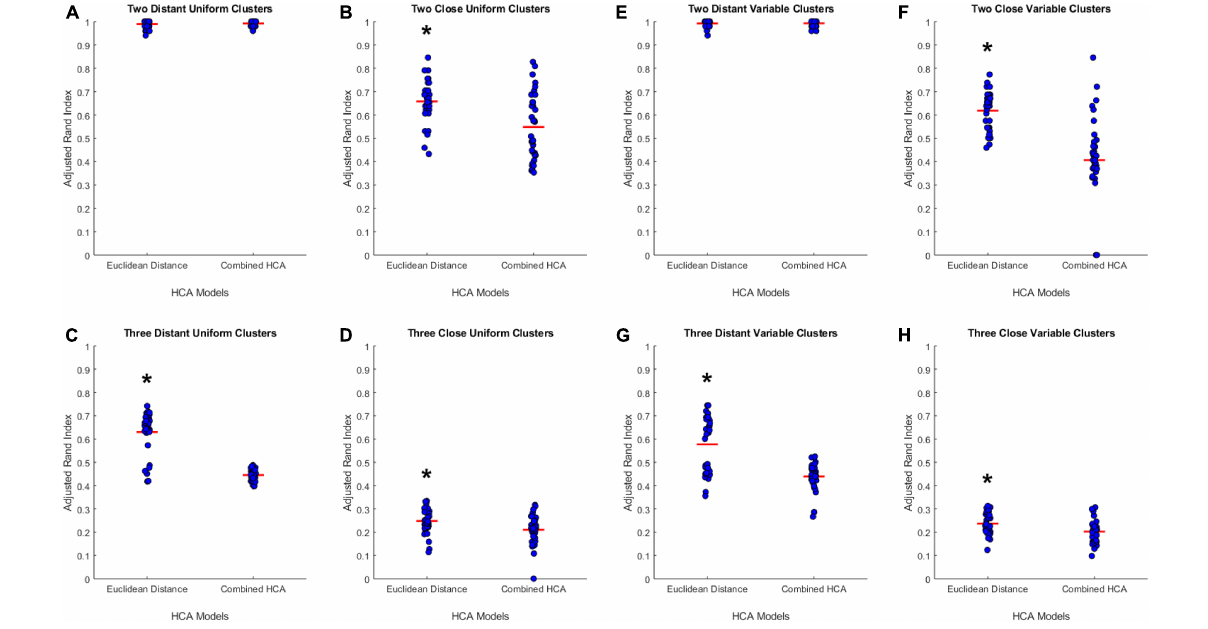
independent samples t -test ( p <